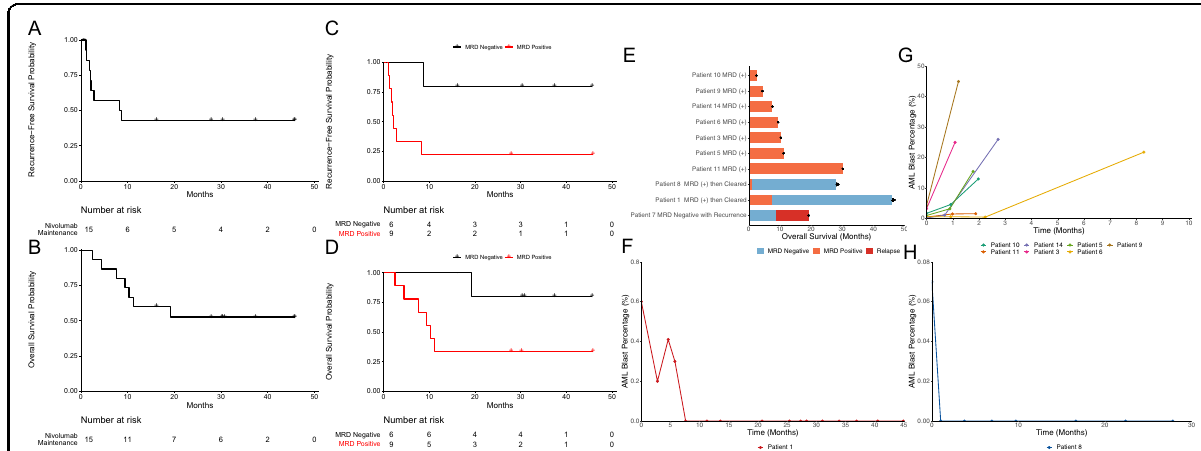
Fig. 1 Survival and MRD Dynamics. A Kaplan – Meier curve showing recurrence-free survival of the fi fteen patients treated with maintenance nivolumab. B Kaplan – Meier curve showing overall survival of the fi fteen patients treated with maintenance nivolumab. C Kaplan – Meier curve showing progression-free survival strati fi ed by MRD status at study enrollment. D Kaplan – Meier curve overall survival strati fi ed by MRD status at study enrollment. E Swimmer plot showing overall survival of nine patients with detectable MRD at enrollment along with one patient with undetectable MRD that relapsed. Black dot represents patient death while black arrow represents ongoing MRD negative CR. F MRD dynamics of the remaining seven patient with positive MRD at enrollment that did not clear MRD while on treatment with maintenance nivolumab. G MRD dynamics of patient #1 as measured by fl ow cytometry while on treatment with maintenance nivolumab. H MRD dynamics of patient #8 as measured by fl ow cytometry while on treatment with maintenance